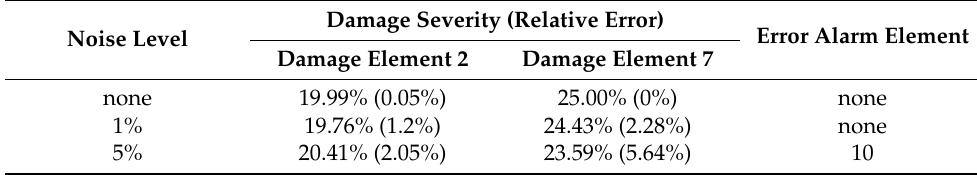
Figure 8. The identification results of the damaged case by MDBA under different noise condi- tions. Table 3. The identification results of the damaged case by MDBA in different noise levels. Noise Level